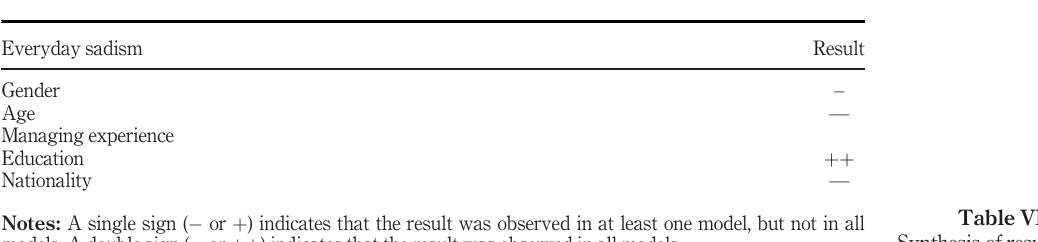
Table VIII. Synthesis of